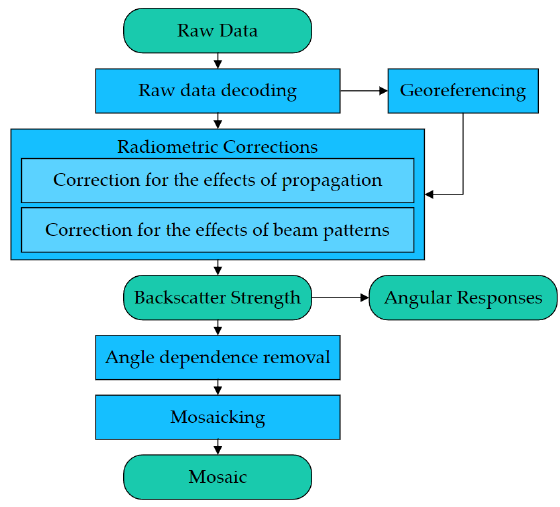
Figure 1. Flowchart of MBES backscatter data processing.